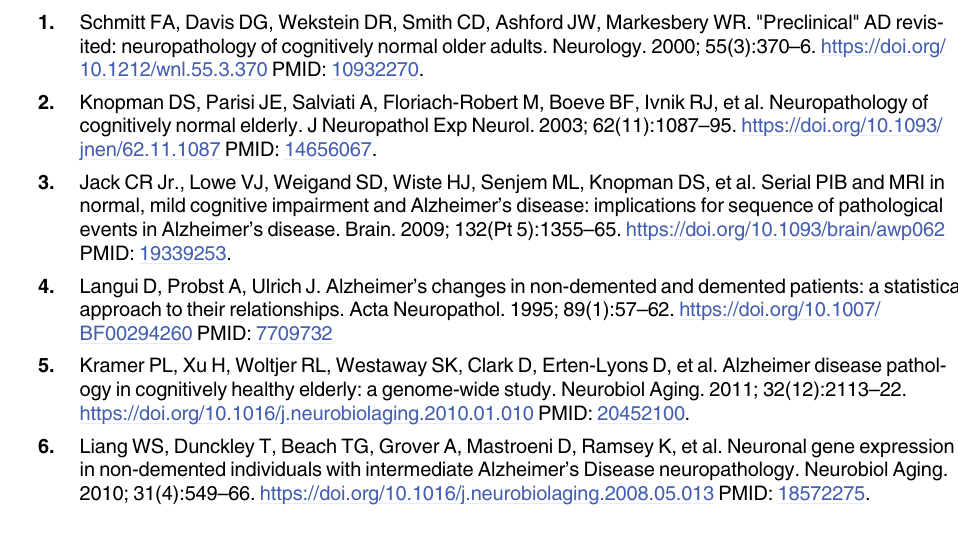
S1 Table. Adjusted P value of Tukey’s multiple comparisons test on synaptic puncta count between sample groups at 72 hours. S2 Table. Adjusted P value of Tukey’s multiple comparisons test on synaptic puncta count between sample groups at 24 hours. S3 Table. Adjusted P value of Dunnett’s multiple comparisons test on synaptic puncta count between control and immunodepletion samples at 72